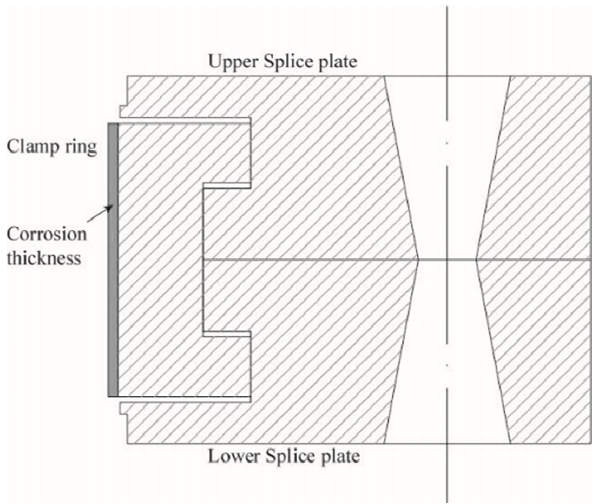
Figure 18. Uniform corrosion of clamp rings.